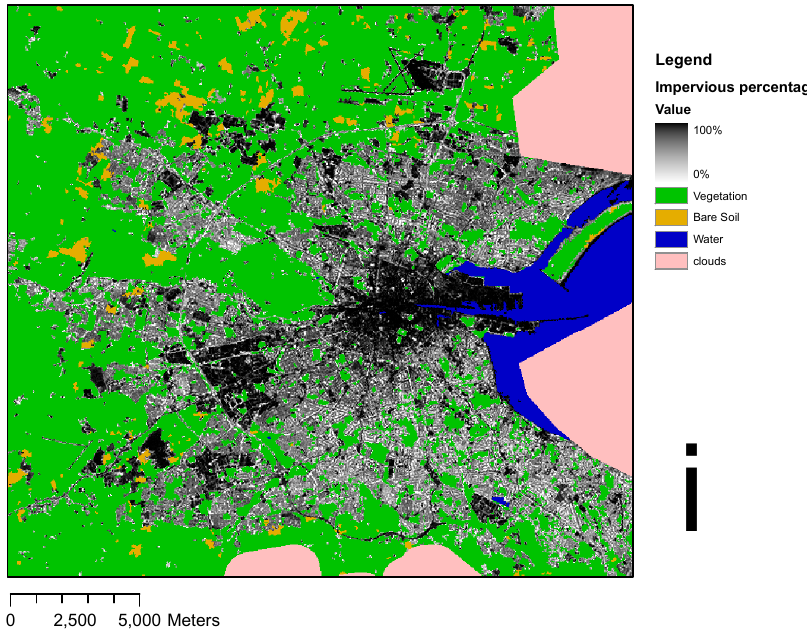
Figure 1. Land-use/land-cover map indicating the percentage of impervious surface within the urban mask in gray shades ([26,30] (with permission from Elsevier)).